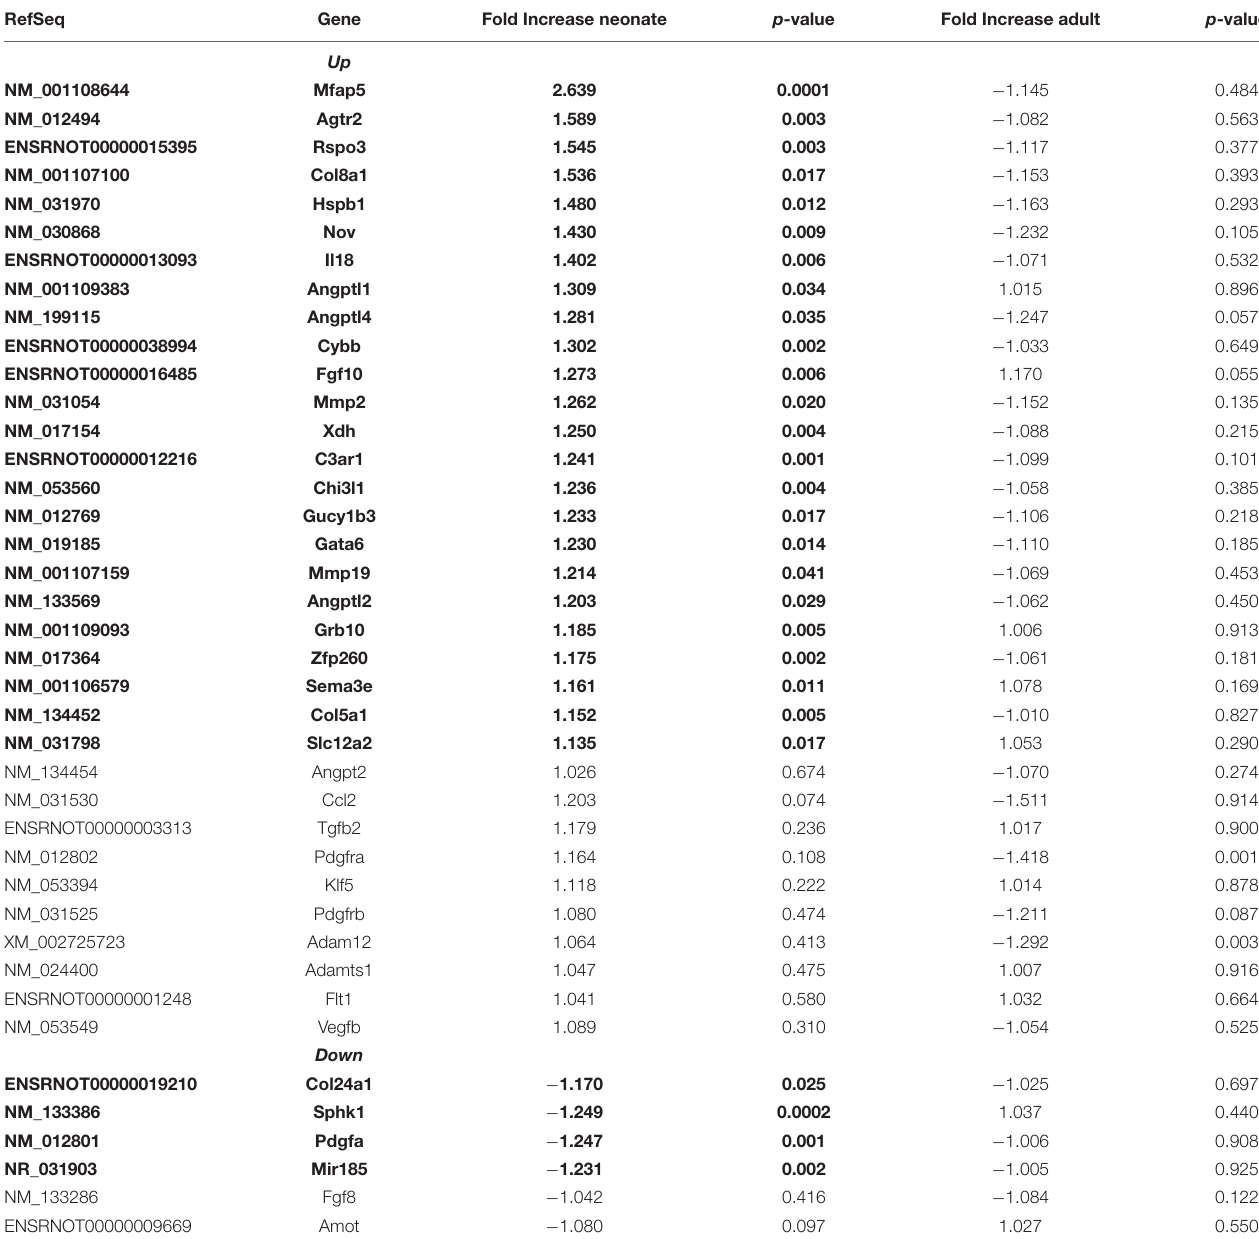
TABLE 2 | Effect of MatSep on angiogenic gene expression trajectory from neonate-to-adult life. RefSeq Gene Fold Increase